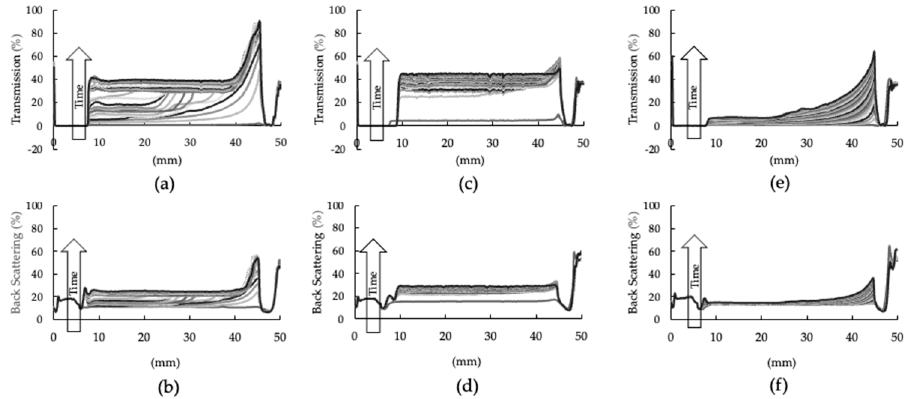
Figure 8. Transmission and backscattering patterns of various suspensions: ( a ) Transmission of RB-T180(GM), ( b ) Back Scattering of RB-T180(GM), ( c ) Transmission of RB-T180 + PVPK-30(GM), ( d ) Back Scattering of RB-T180 + PVPK-30(GM), ( e ) Transmission of RB-T180 + HPC-L(GM), and ( f ) Back Scattering of RB-T180 + HPC-L(GM).